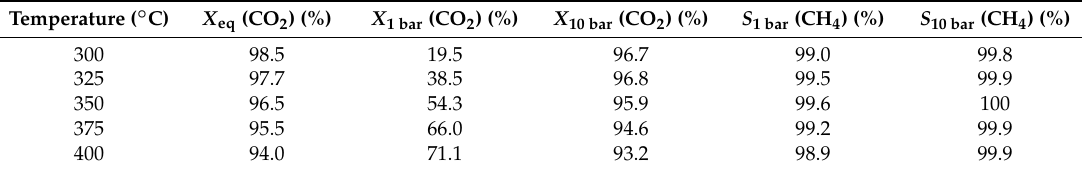
Table 1. Carbon dioxide conversion and methane selectivity at 300–400 ◦ C at different reaction